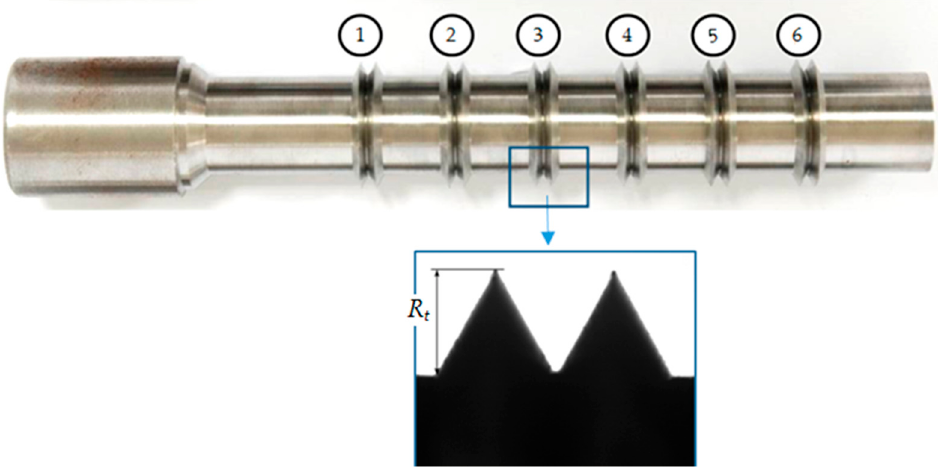
Figure 4. General view of the shaft with the samples after turning process and zoom of the sample (nb 3) after turning process, where R t is the asperity height.